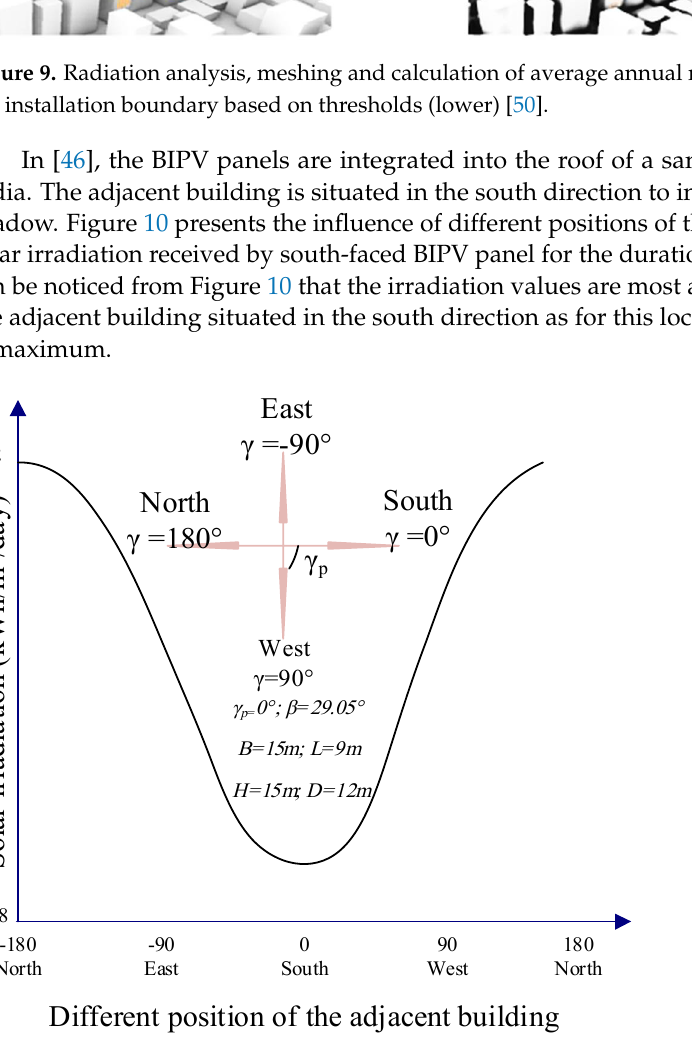
Figure 10. Variation of monthly average daily irradiation with different positions of the adjacent building (width of the adjacent building, B = 15 m, length of the adjacent building, L = 9 m, relative height of the adjacent building, H = 15 m, horizontal distance of the adjacent building from BIPV panel, D = 12 m) at inclination angle of BIPV panel, φ = 28.70°, when the BIPV panel is south facing, September 2017 [51].